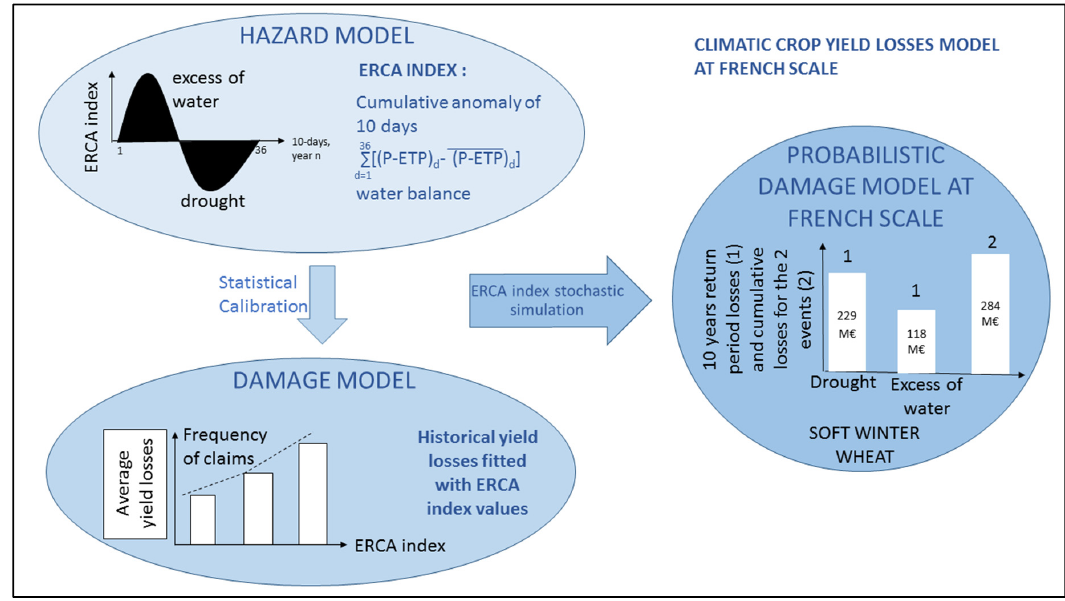
Figure 1. Schematic representation of the general methodology of the model: from climatic index to stochastic loss modeling.